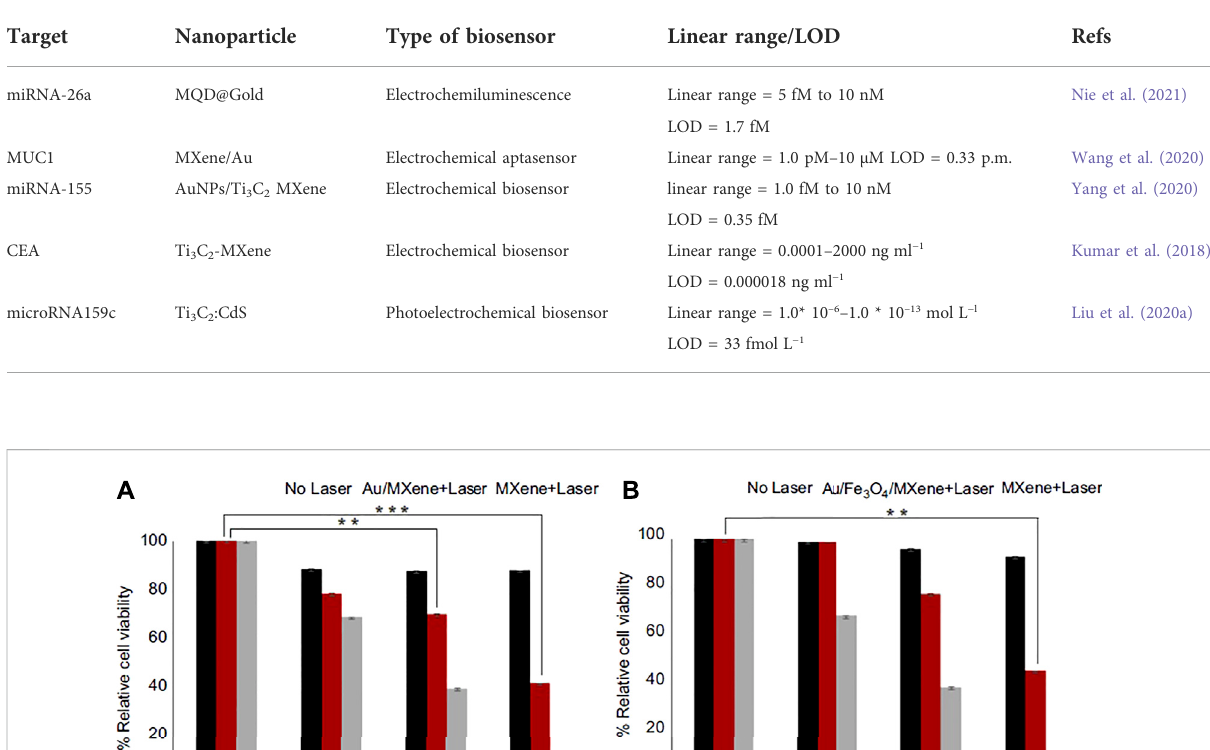
TABLE 2 The types of MXene-based biosensors for detecting breast cancer.